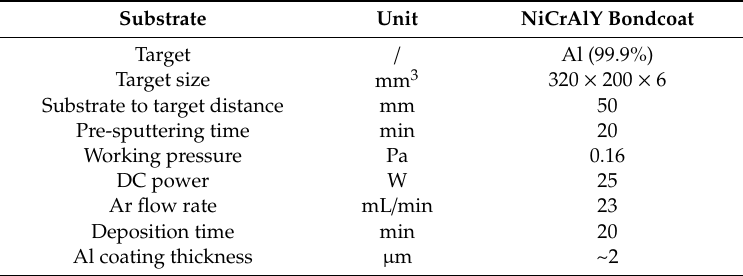
Table 3. Sputtering conditions on the surface of NiCrAlY